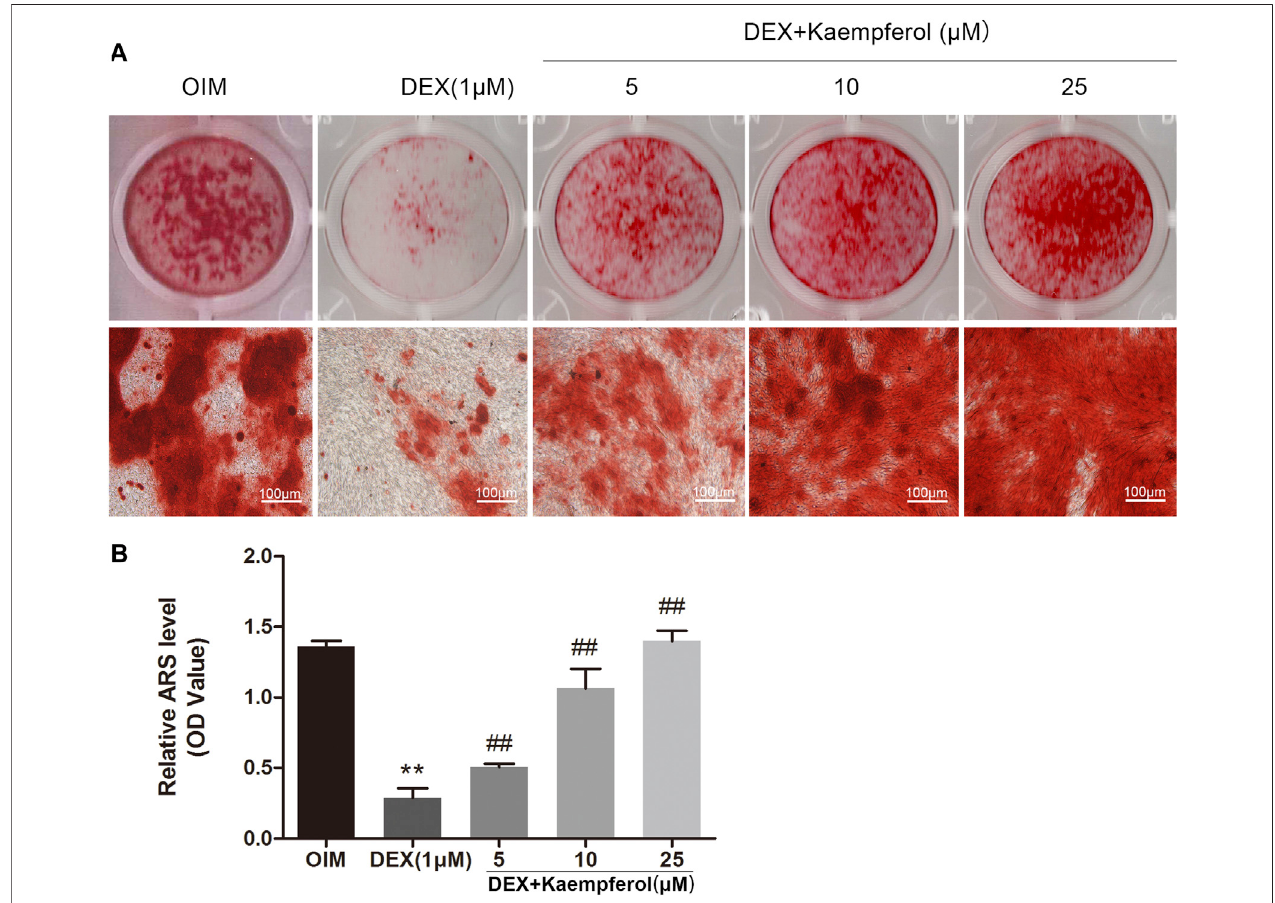
FIGURE 6 | The effect of kaempferol on the mineralization of DEX-treated MC3T3-E1 cells. (A) Alizarin red S was used for staining on day 14. (B) The calci fi ed nodules was quanti fi ed by extraction of alizarin red S with 10% cetylpyridinium chloride (CPC) on day 14. ** p < 0.01 vs. OIM; ## p < 0.01 vs. DEX.